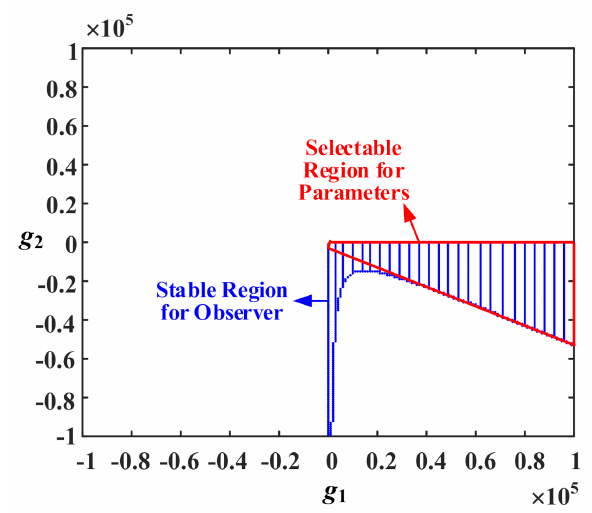
Figure 9. Stable region for parameter g 1 and g 2 obtained by parameter scan.